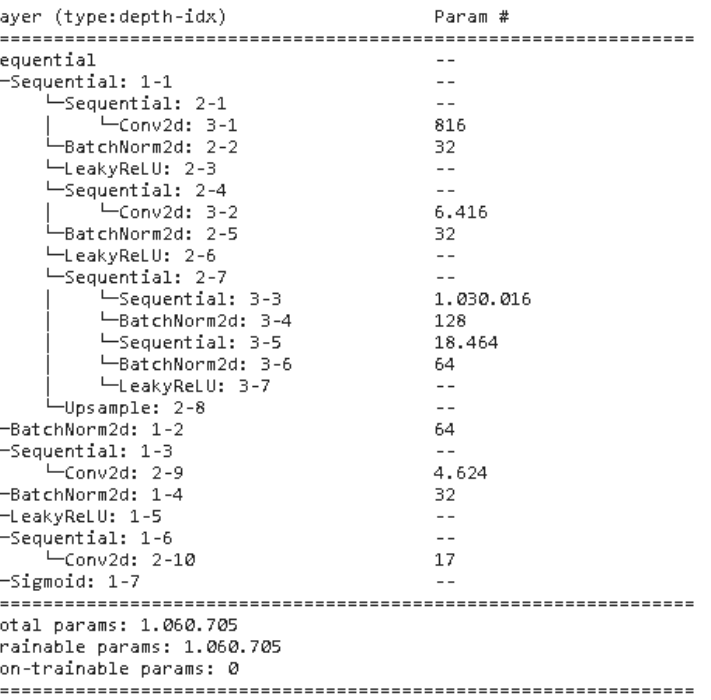
Figure 5. Deep Image Prior Model Graph.